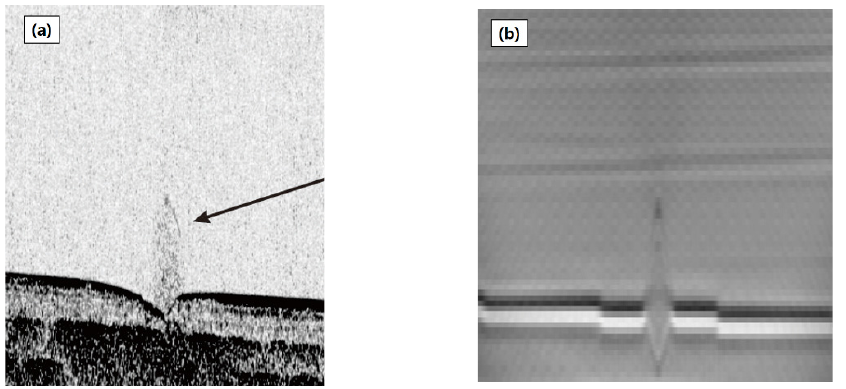
Figure 9. Comparison of Chirp section and numerical images: ( a ) AF above pockmark in Figure 1d; ( b ) enlarged AF area of Figure 7d.